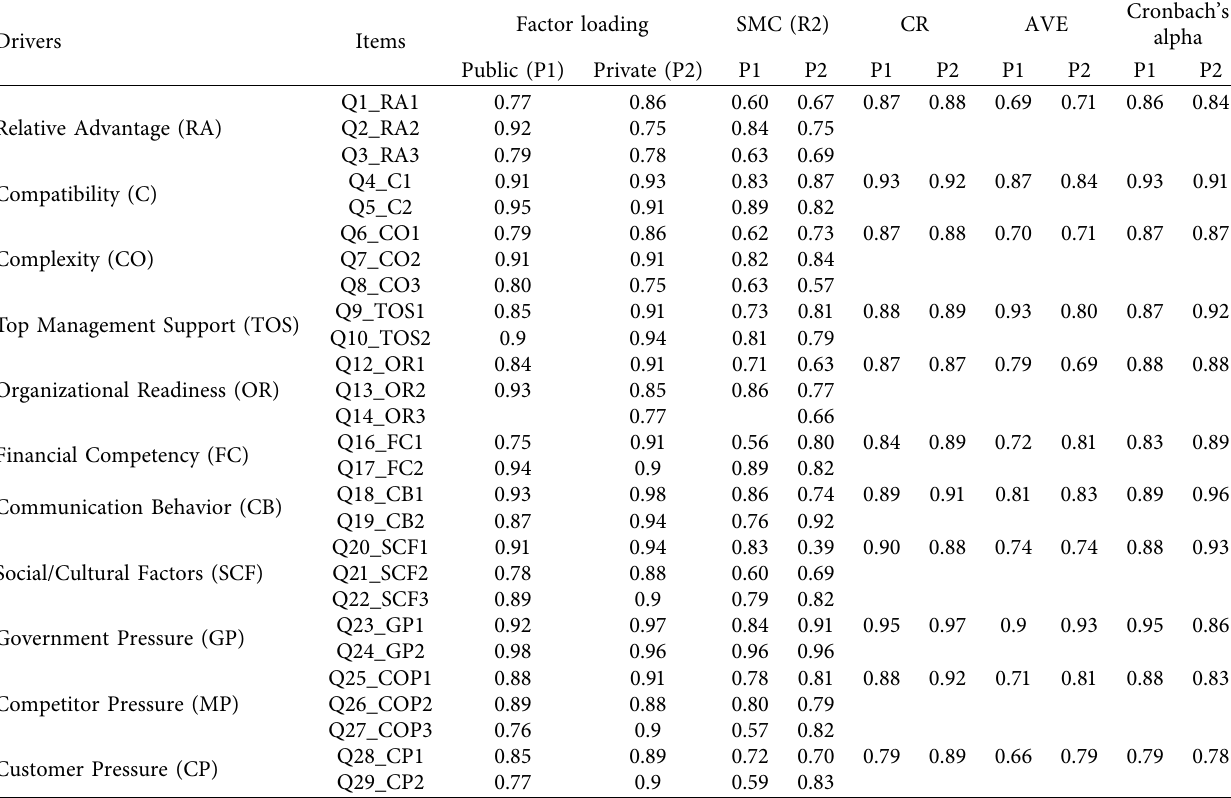
Table 7: Summary of the measurement model result for public and private projects.